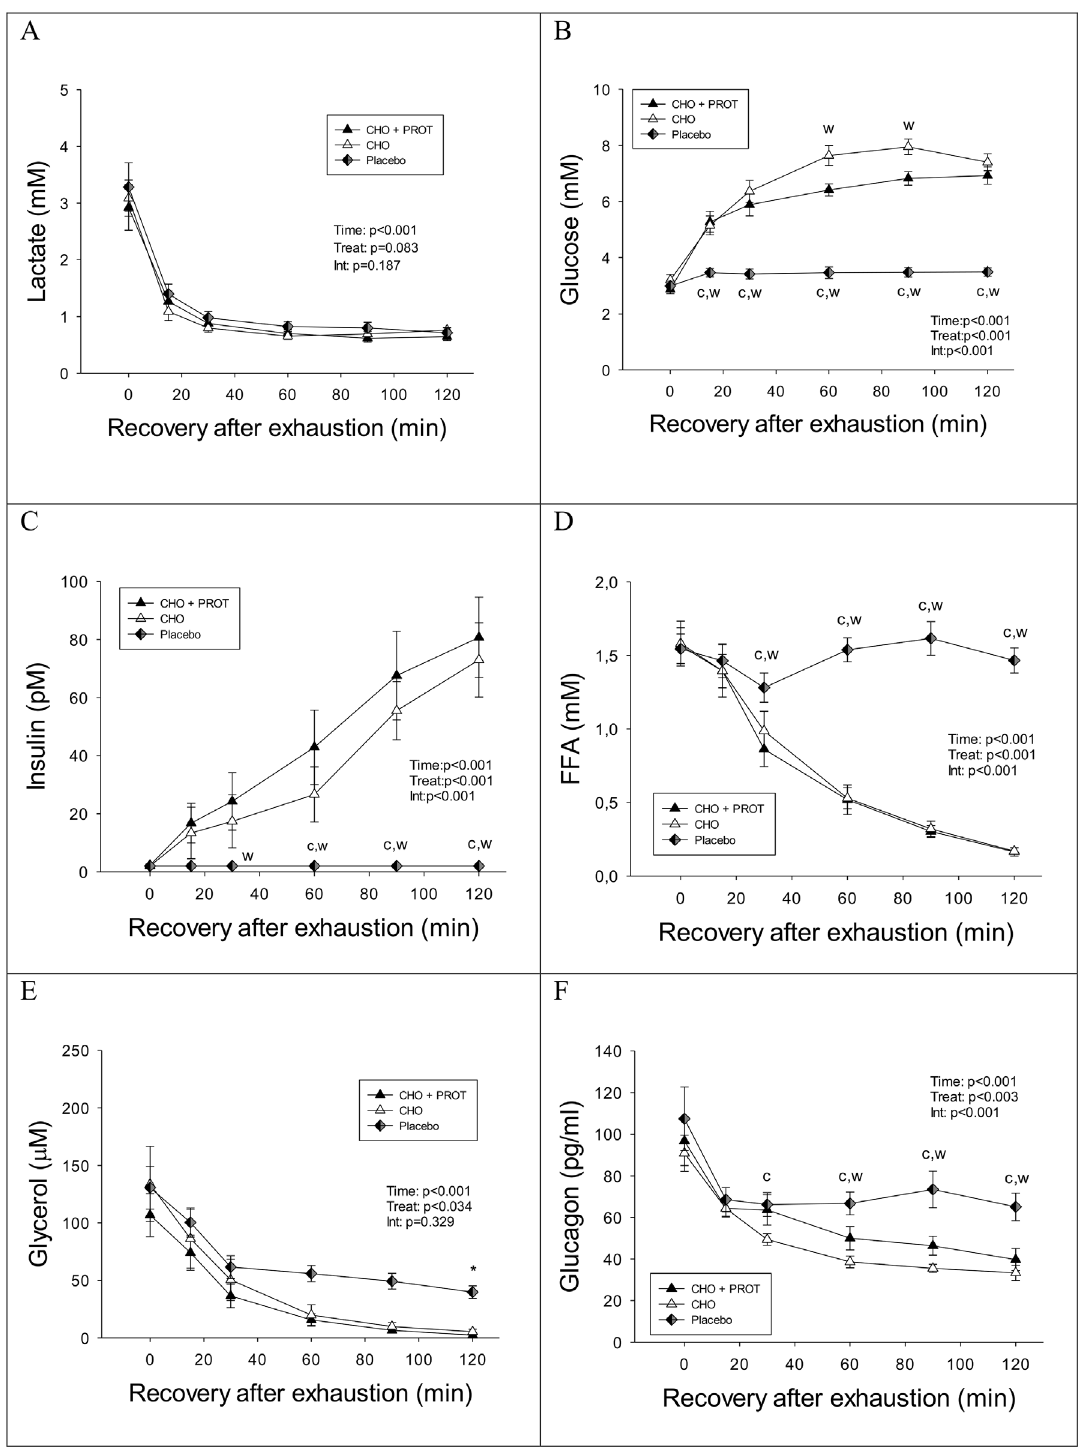
Fig 2. Plasma concentrations of lactate, glucose, insulin, FFA, glycerol and glucagon during the first 2 h recovery when provided CHO, CHO +PROT or PLA. Data are mean and error bars represents SEM. C: p < 0.05 compared to CHO; W: p < 0.05 compared to CHO+PROT (whey); P: p < 0.05 compared to placebo. N = 8 for all data